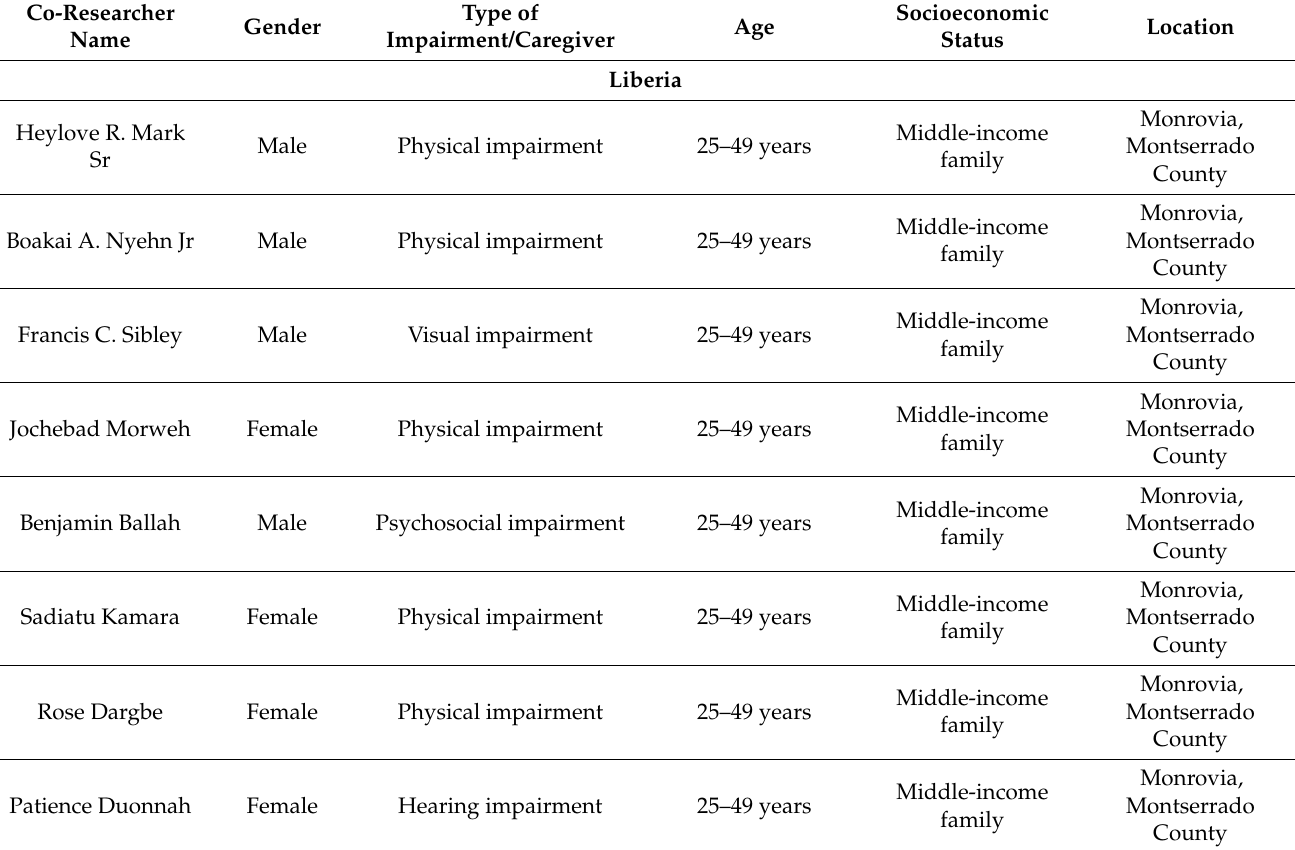
Table 1. Photovoice